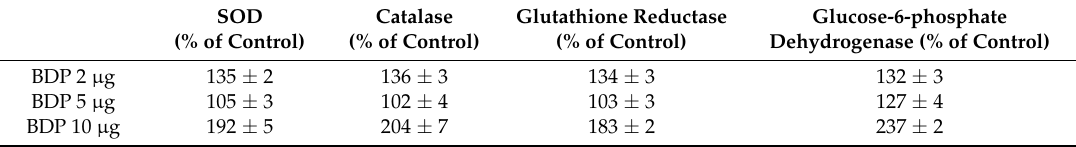
Table 4. Dose-dependent effects of BDP on biochemical indexes of nontumor rat blood. SOD Catalase Glutathione Reductase Glucose-6-phosphate (% of Control) (% of Control) (% of Control) Dehydrogenase (% of Control) BDP 2 µ